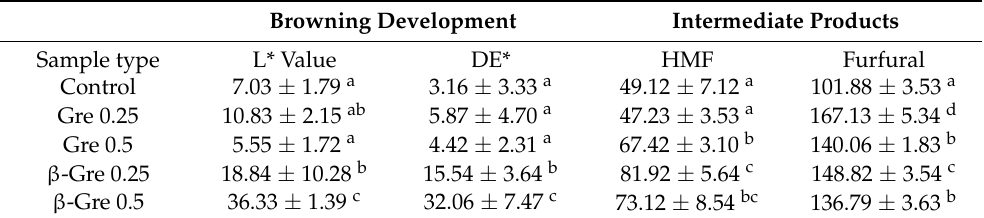
Table 3. Activation energy (kJ.mol − 1 ) of green rooibos extracts against browning of canned apples during storage.